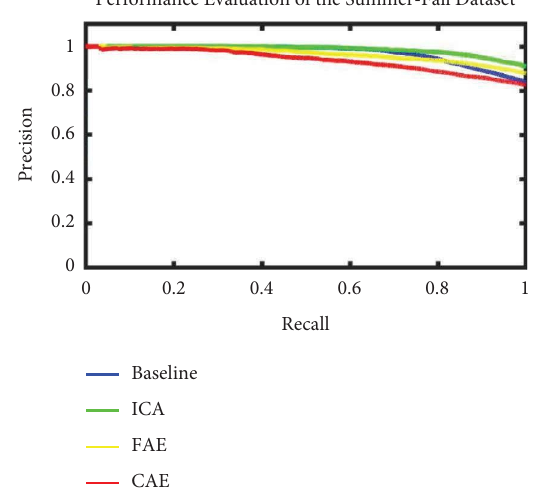
Figure 9: Precision-recall curves of the baseline and proposed algorithms on the summer-fall dataset.